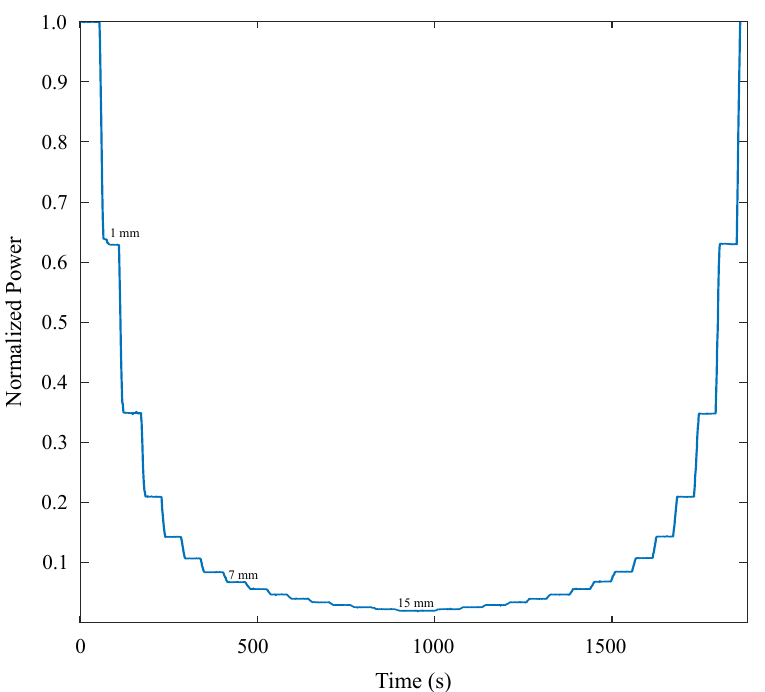
Figure 7. Optical strain-gauge dynamic response to axial displacement. Experiment was carried out by increasing axial displacement in steps of 1 mm and remaining in each position for a considerable period of time to analyze signal stability at each point, starting from zero displacement (maximum light coupling), until a maximum displacement of 15 mm, where almost the maximum light decoupling (reflected in the transmitted power) was presented. Once the sensor reached axial displacement of 15 mm, it was returned to the original position following the same procedure.